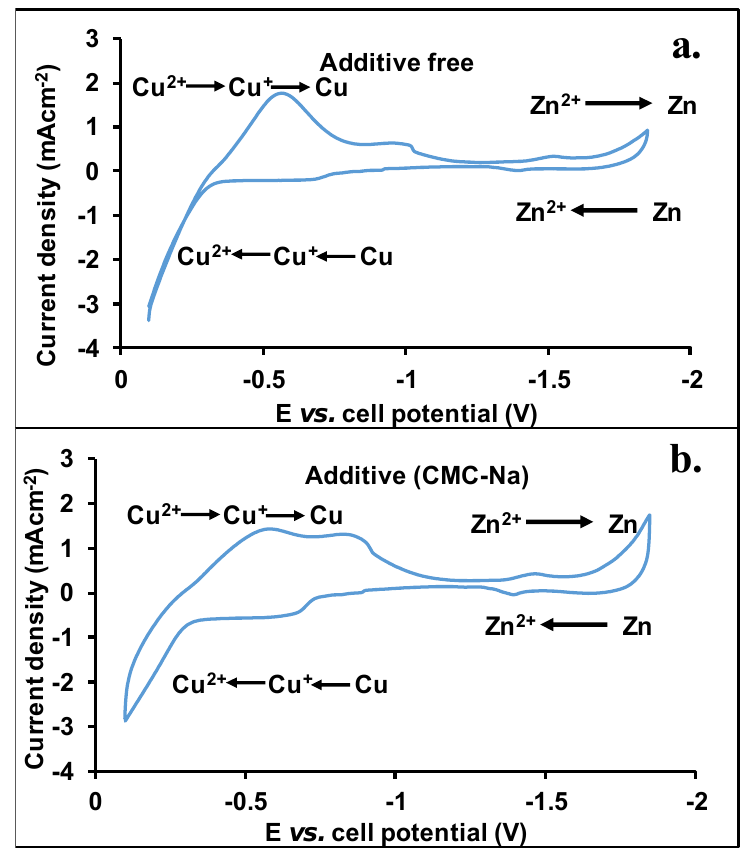
Figure 1. Cyclic voltammograms recorded in the absence ( a ) or presence of CMC-Na salt additive ( b ), applying brass anode. The KOH and K 2 [(Zn(OH) 4 )] concentrations in the electrolytes were 6.0 M and 0.25 M, respectively.